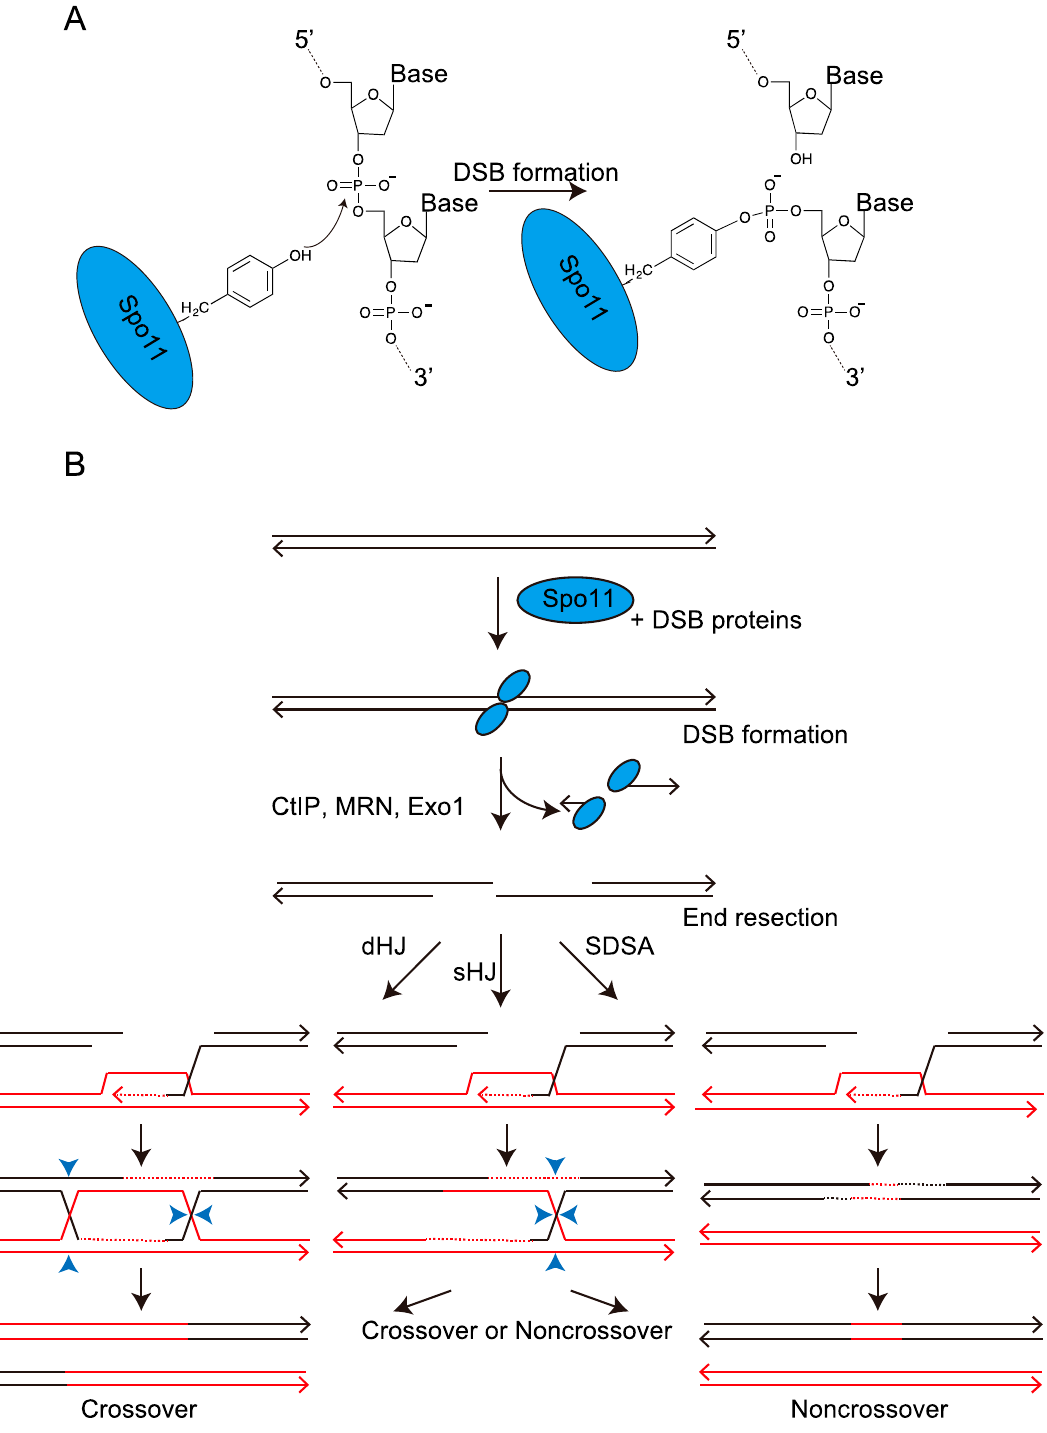
Figure 1. Meiotic double-strand break (DSB) formation and homologous recombination induced by the programed DSBs. ( A ) Mechanism of the DSB formation catalyzed by Spo11 protein. The tyrosine (Tyr) side chain on the Spo11 protein carries out nucleophilic attack on the DNA phosphodiester backbone. This transesterase reaction cuts the DNA backbone and covalently links the Spo11 protein to the DNA end via a tyrosyl phosphodiester linkage. Spo11 protein is represented by a blue circle. ( B ) Schematic representation of meiotic recombination. Spo11 protein is represented by a blue circle. Homologous donor DNA is indicated by the red line. Only one of the two sister chromatids from each homolog has been shown.